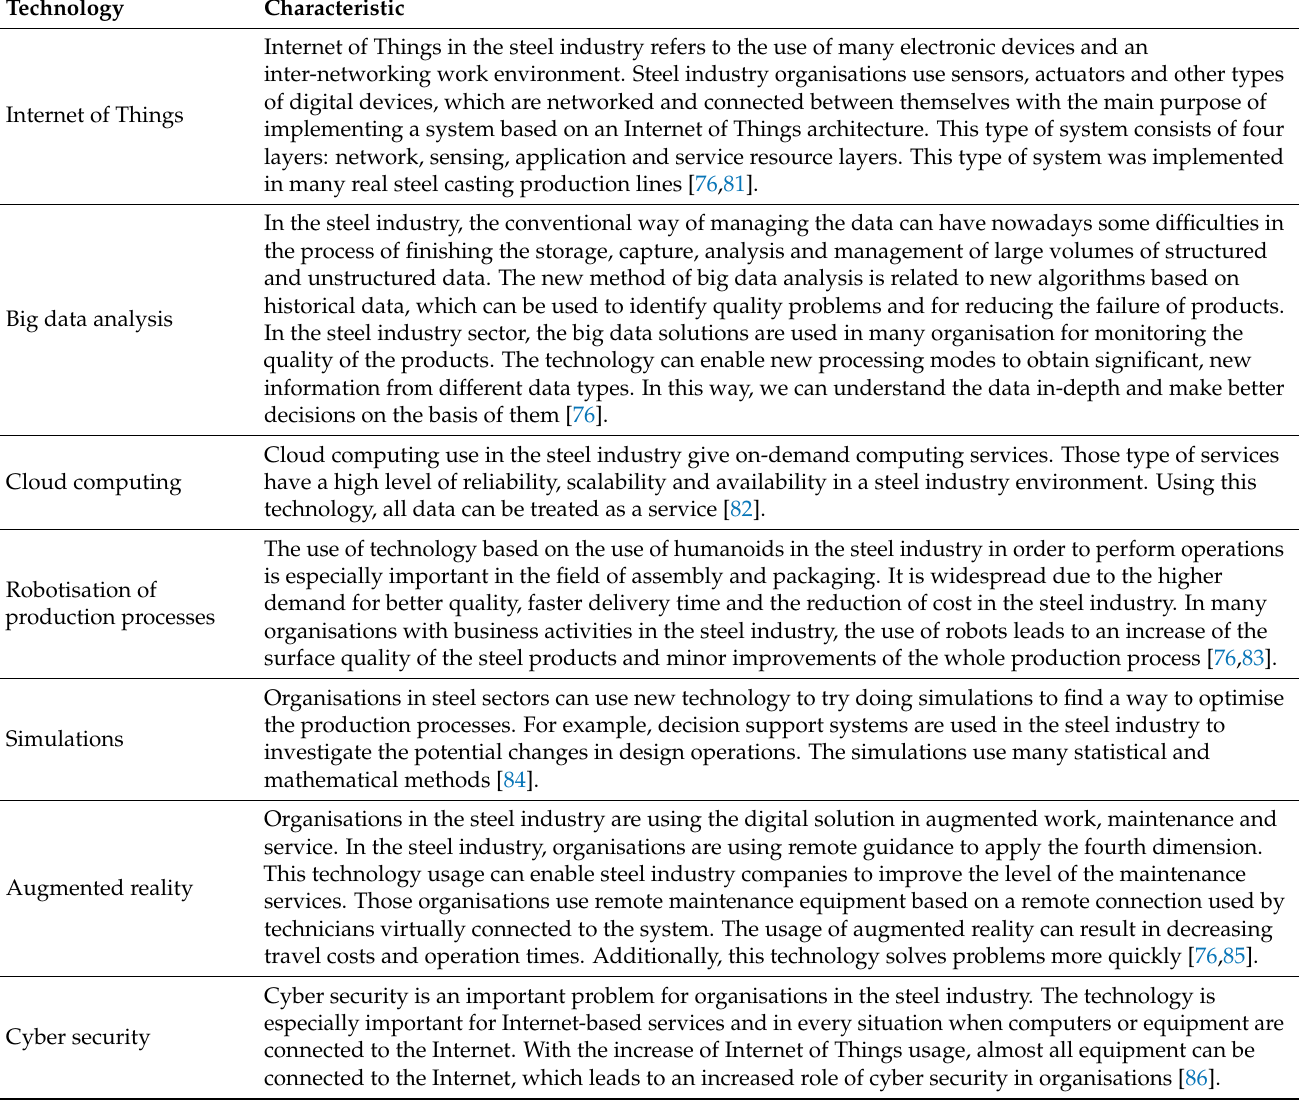
Table 1. Digital technologies used in the steel